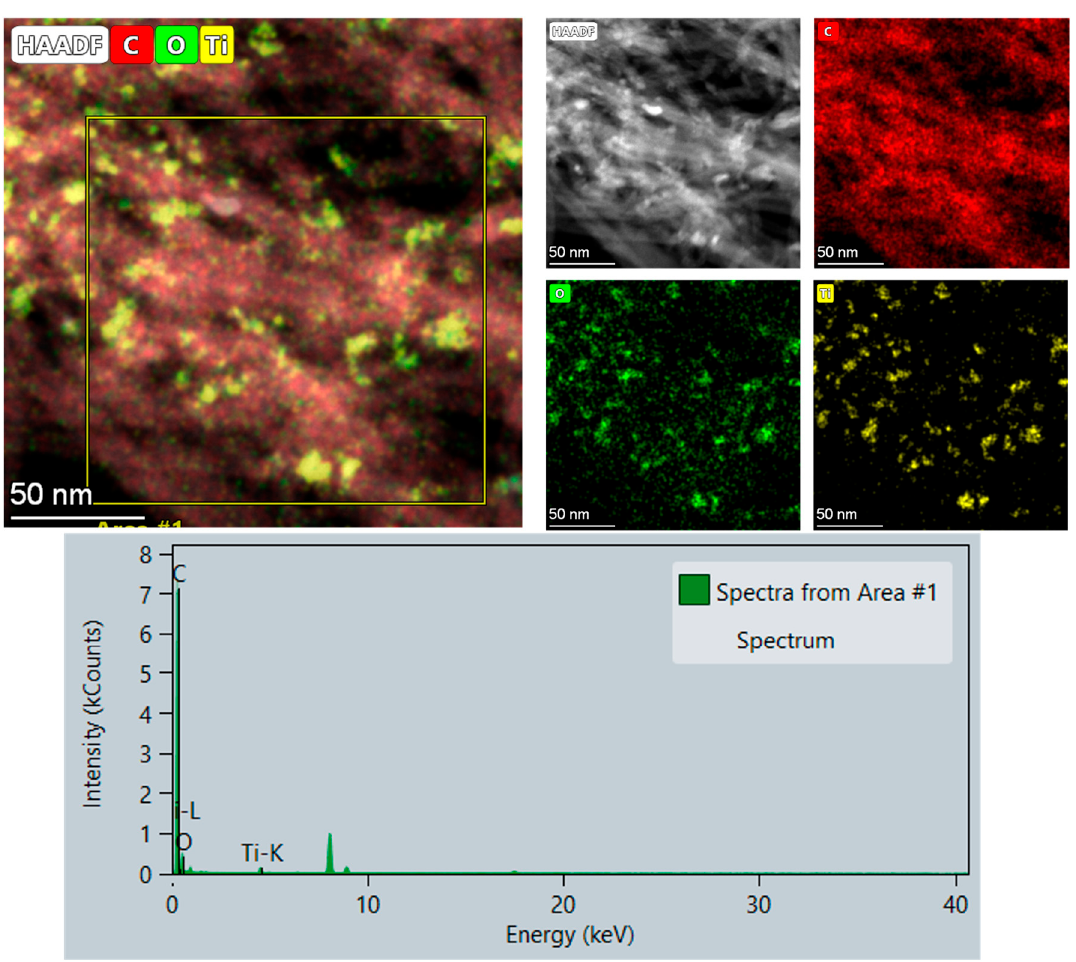
Figure 2. Energy-dispersive spectroscopy (EDS) mapping of the TiO 2 /CNT mesoporous nanomateri- als.